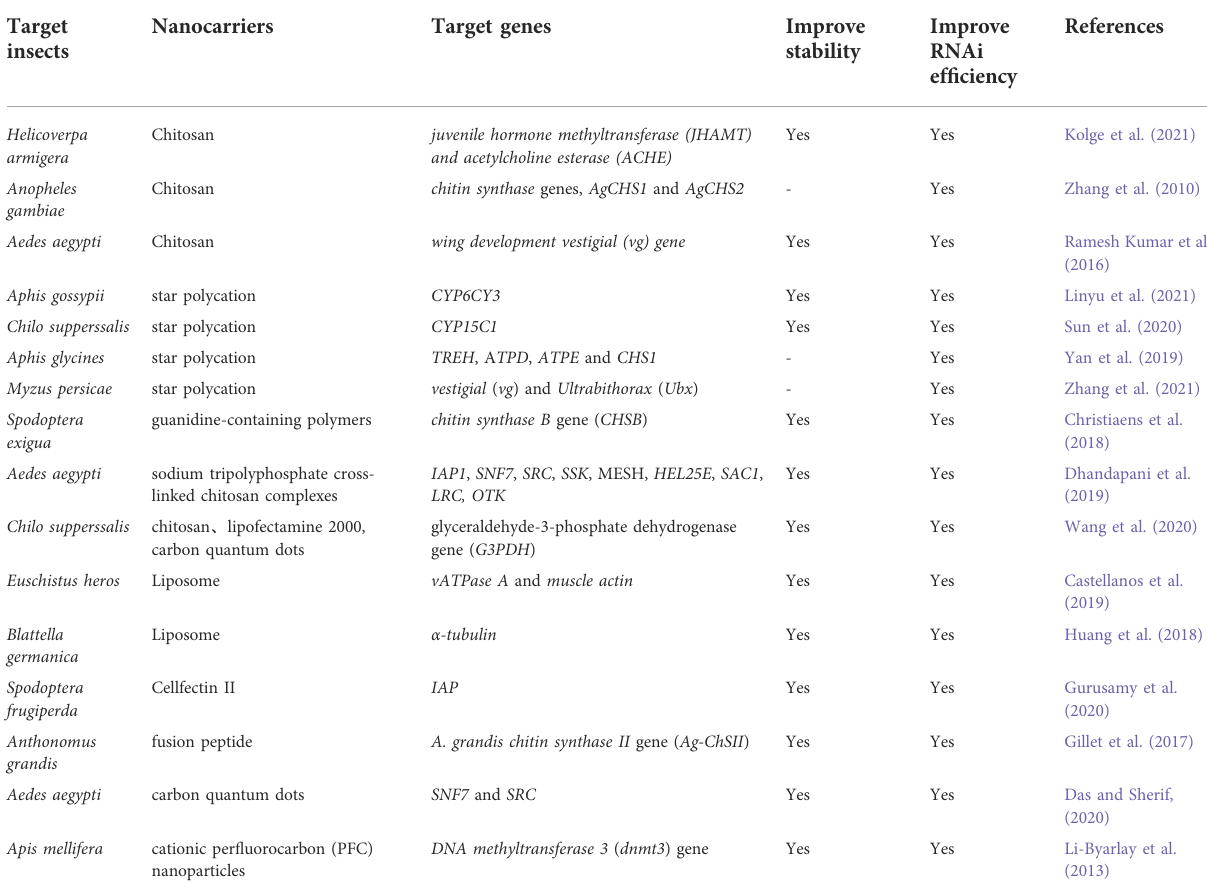
TABLE 1 Various nanocarriers to improve the stability of